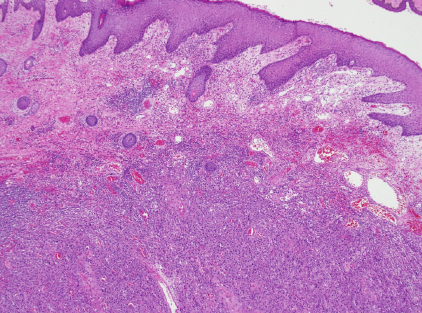
Figure 2: Pathologic slide demonstrating normal dermis (superior), inflammatory infiltrate (inferiorly), and well-differentiated Squa- mous Cell Carcinoma